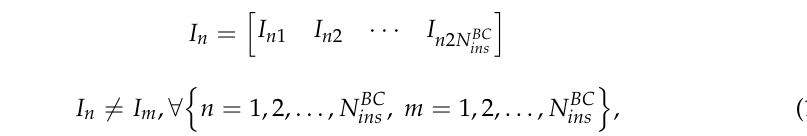
Figure 1. Codification proposed for each